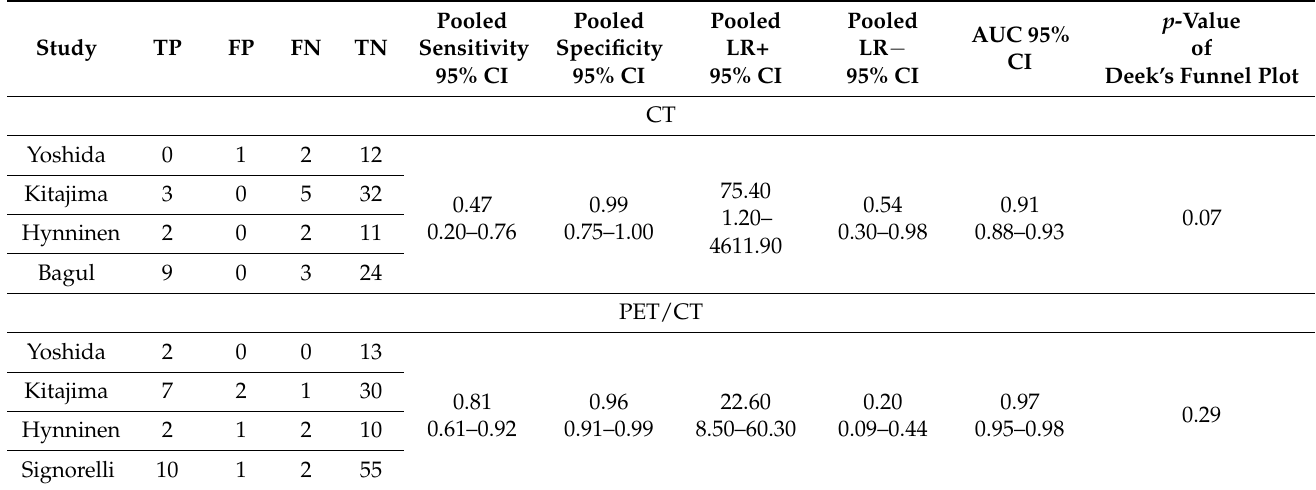
Figure 2. QUADAS-2 risk of bias and applicability concerns. Table 2. Diagnostic accuracy of preoperative CT and PET/CT for detecting lymph node